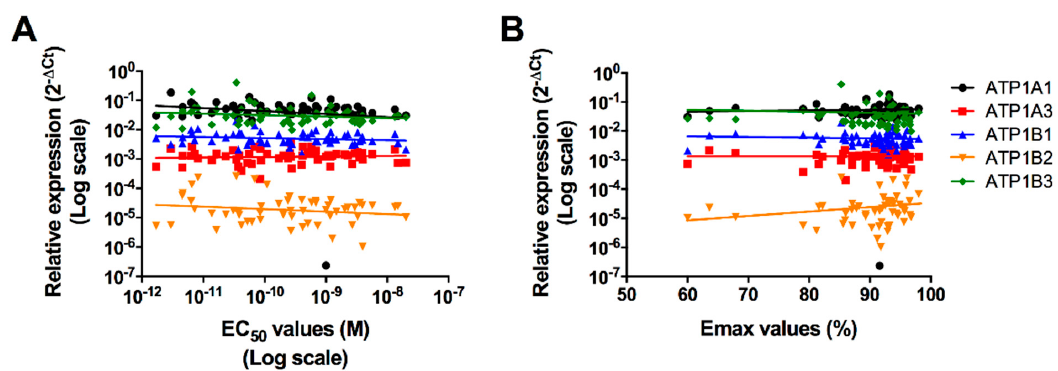
Figure 4. Dispersion graphs of the relative gene expressions of the Na + / K + -ATPase subunits isoforms recorded in monocytes from the 60 healthy volunteers in function of the EC 50 ( A ) or the Emax ( B ) values, and the relevant regression lines. Each point represents the mean EC 50 or Emax values recorded for each volunteer.